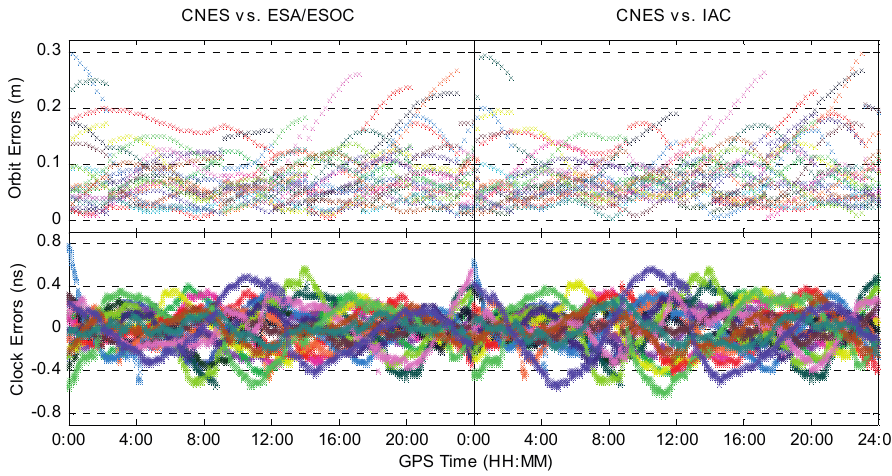
Figure 1. Errors of CNES (Centre National d’Études Spatiales) GLONASS satellite orbit and clock corrections with respect to the ESA/ESOC (European Space Agency/European Space Operations Centers) and IAC (Information-Analytical Center) products on 1 February